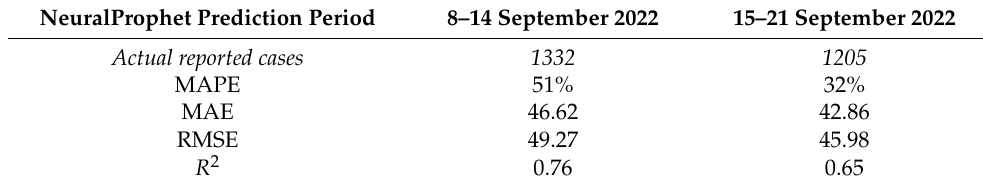
Table 2. NeuralProphet comparison between validation and testing